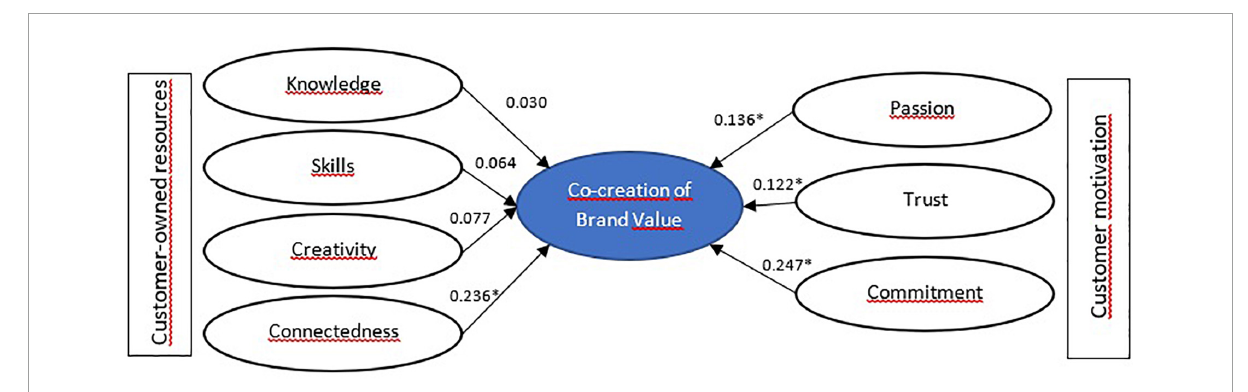
FIGURE4 Model estimation for neutral customers—Segment 3. ∗ p <